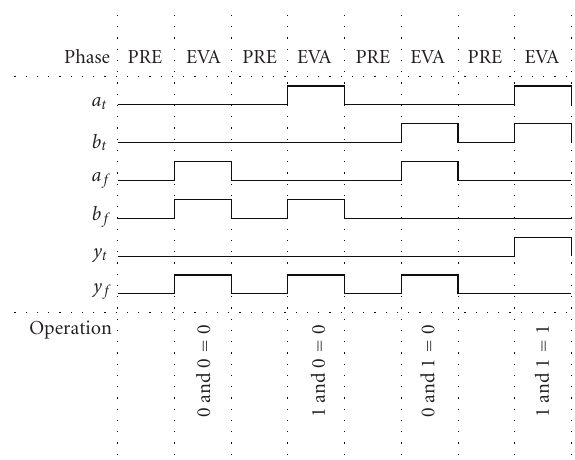
Figure 2: Secure return-to-null protocol for a constant activity of the WDDL AND gate depicted in Figure 1.